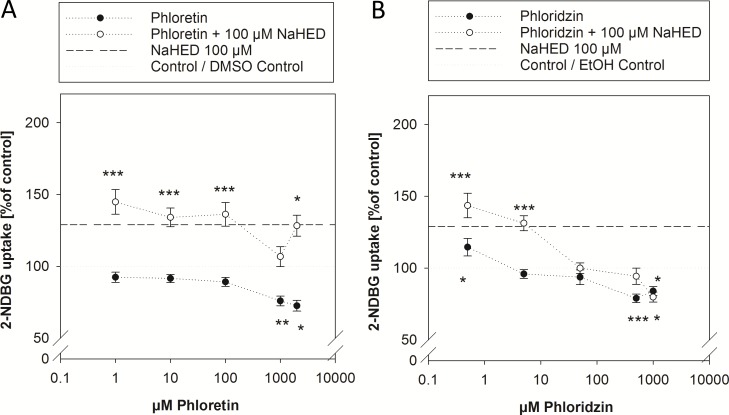
2-NBDG uptake by differentiated Caco-2 cells after 30 min pre-treatment with 1 μM to 2 mM phloretin (2A) or 0.5 μM to 1 mM phloridzin (2B) with or without addition of 100 μM HED sodium salt. Data are calculated in comparison to the corresponding solvent control (100%) after excluding an effect of the solvent on glucose uptake. Standard error means of the used controls were 100 ± 6.78% for 0.1% DMSO control (A), 100 ± 4.06% for 0.1% EtOH control (B), and 100 ± 3.85% for the buffer control (not shown). Control values were set to 100% and are depicted using a grey line. Pre-incubation with 100 μM HED sodium salt increased glucose uptake by an average of 29.0 ± 3.90% and is symbolized by a dotted black line. Statistics: n = 3–6 with multiple technical replicates. Significant differences between the treatments and control treated cells were assessed using one-way ANOVA vs. the corresponding solvent control with Holm-Sidak post hoc test and are marked by * p <0.05, ** p<0.01, *** p< 0.001.